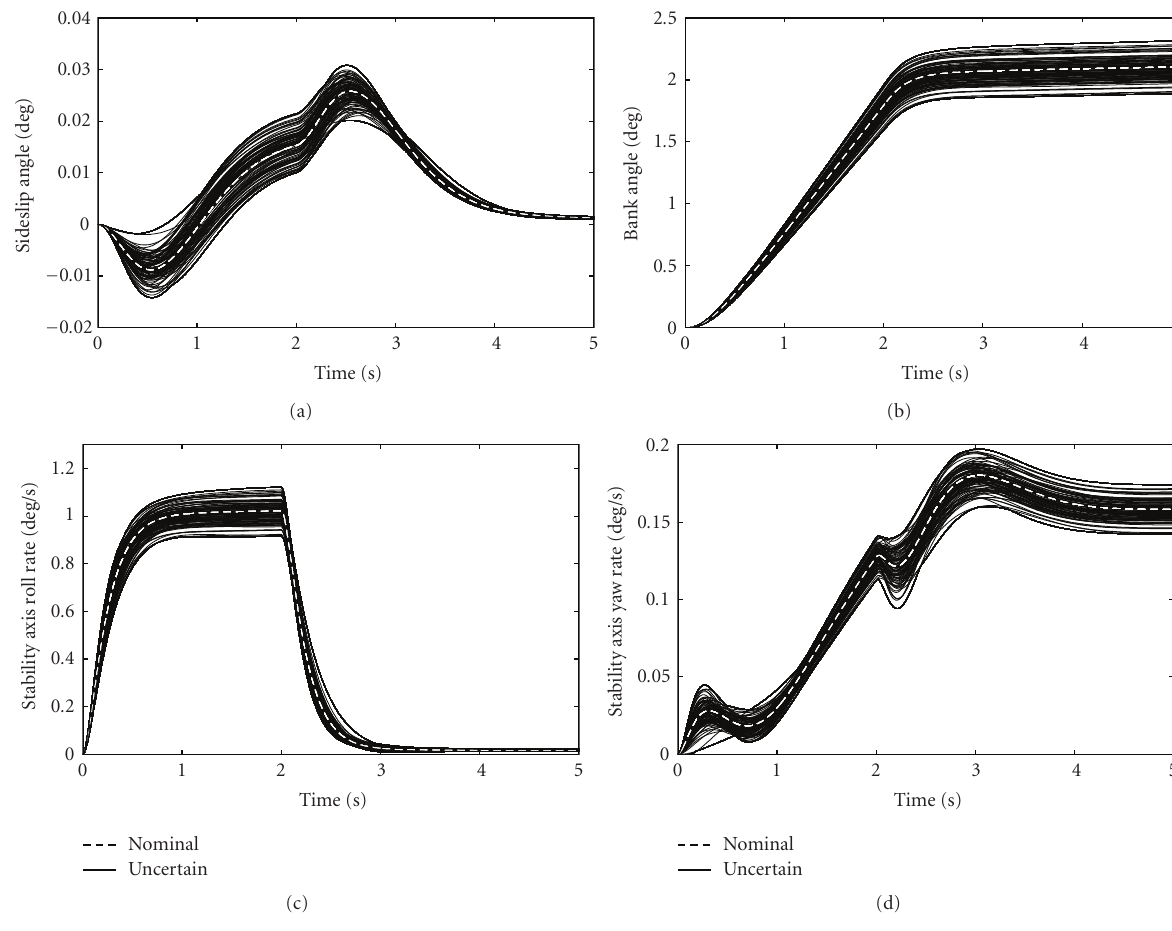
Figure 4: Monte carlo simulation for lateral dynamics.